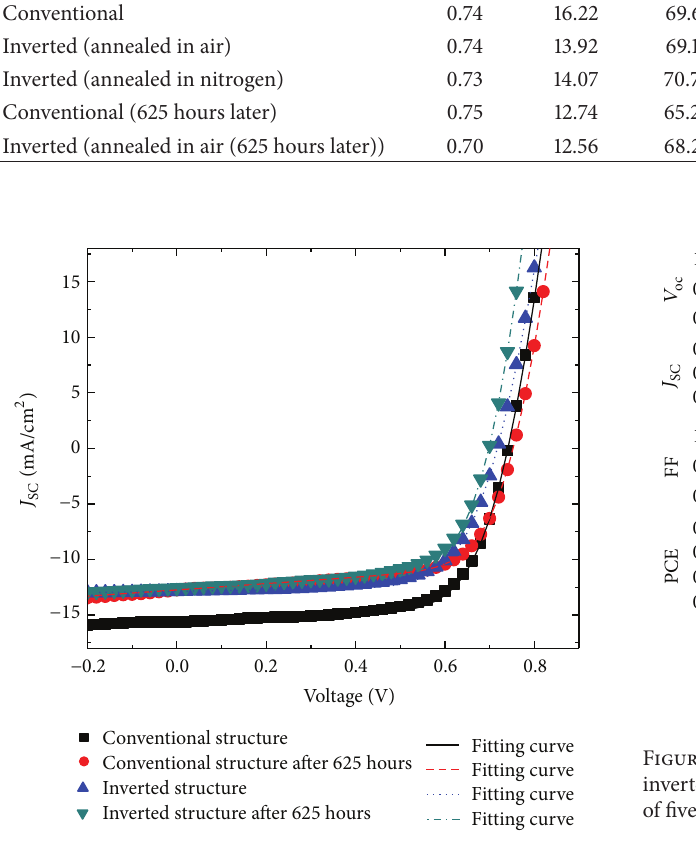
Figure 2: Measured (symbol) and calculated (line) J - V character- istics for conventional and inverted PSCs with ZnO as ETL under the simulated AM 1.5G illumination of 100 mW/cm 2 fresh or stored after 625 hours.